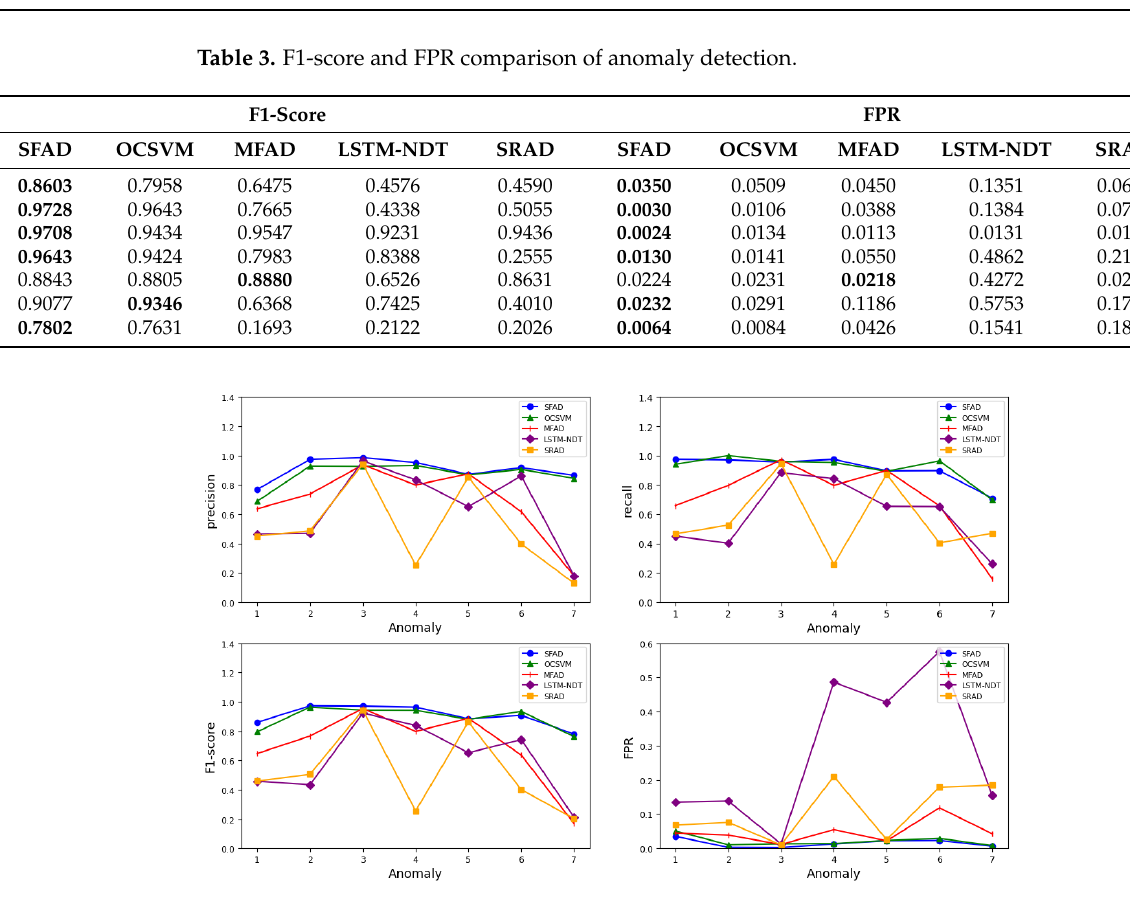
Table 2. Precision and recall comparison of anomaly detection.